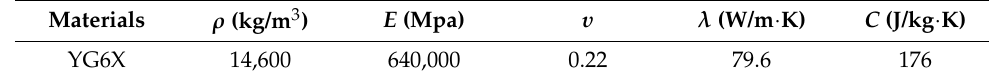
Table 8. The material parameters of the